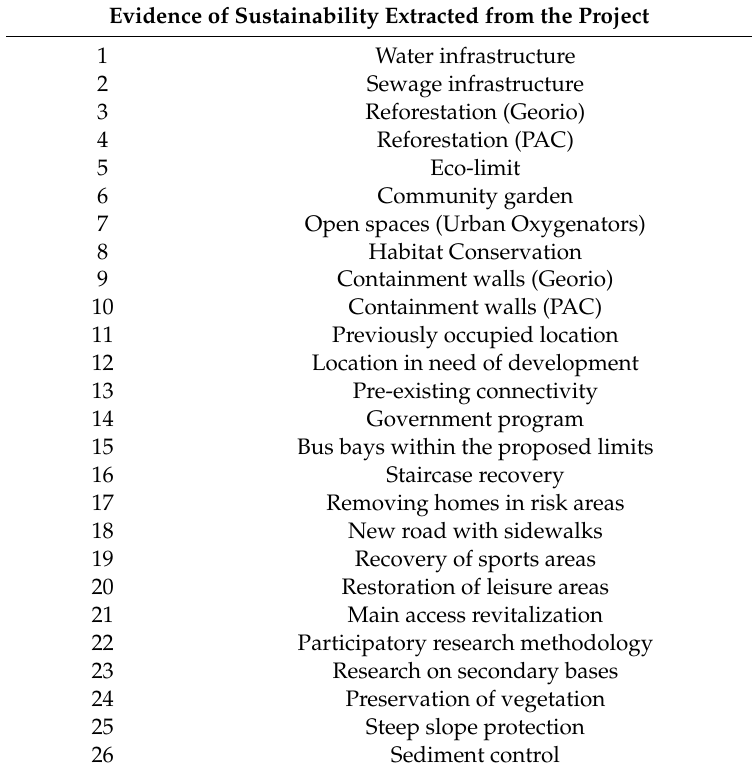
Table 2. Morro do Encontro: evidence of sustainability identified in the